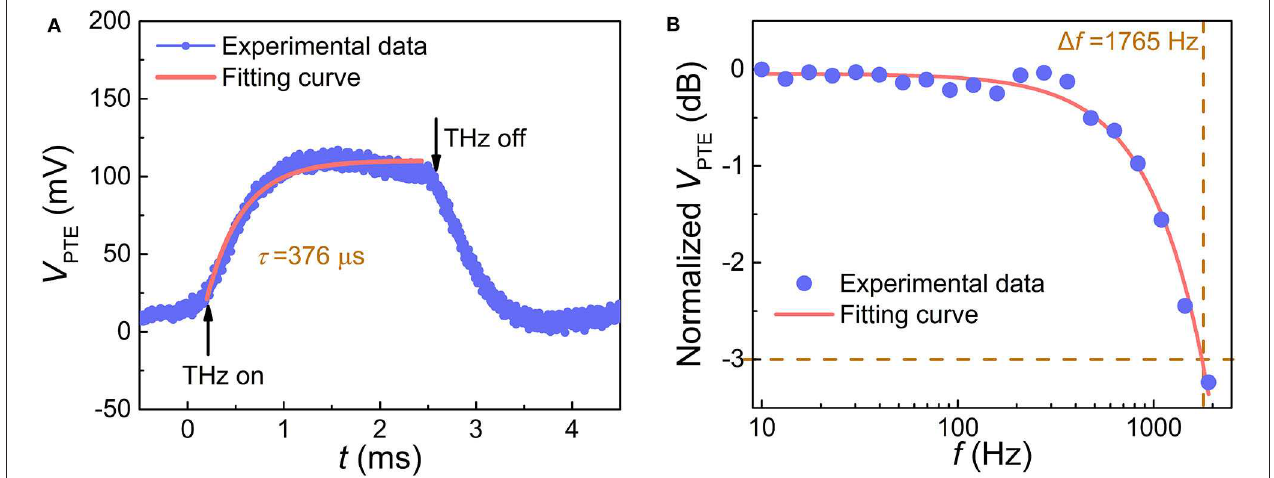
FIGURE 6 | (A) THz on/off switching curve and (B) modulation frequency dependent response of the graphene device under 2.52 THz